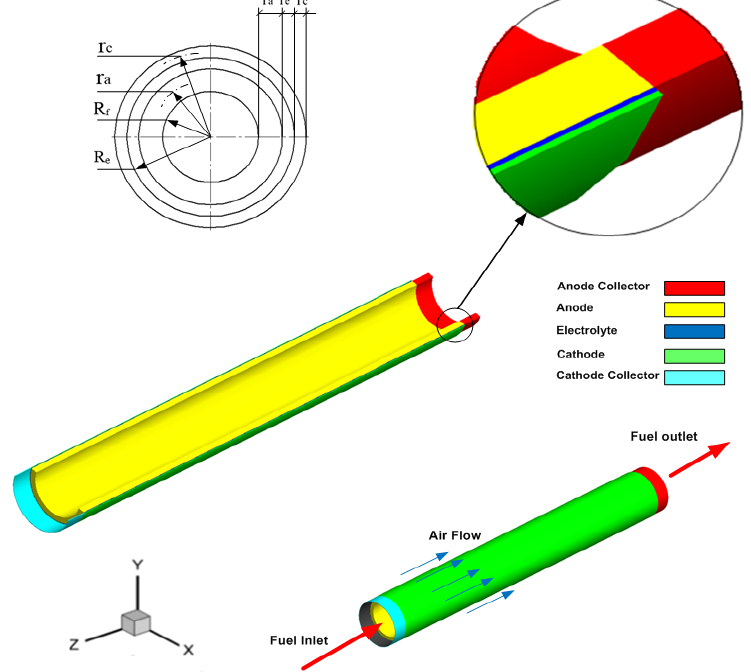
Figure 2. The model geometry used in the analysis (traditional design of a tubular SOFC).